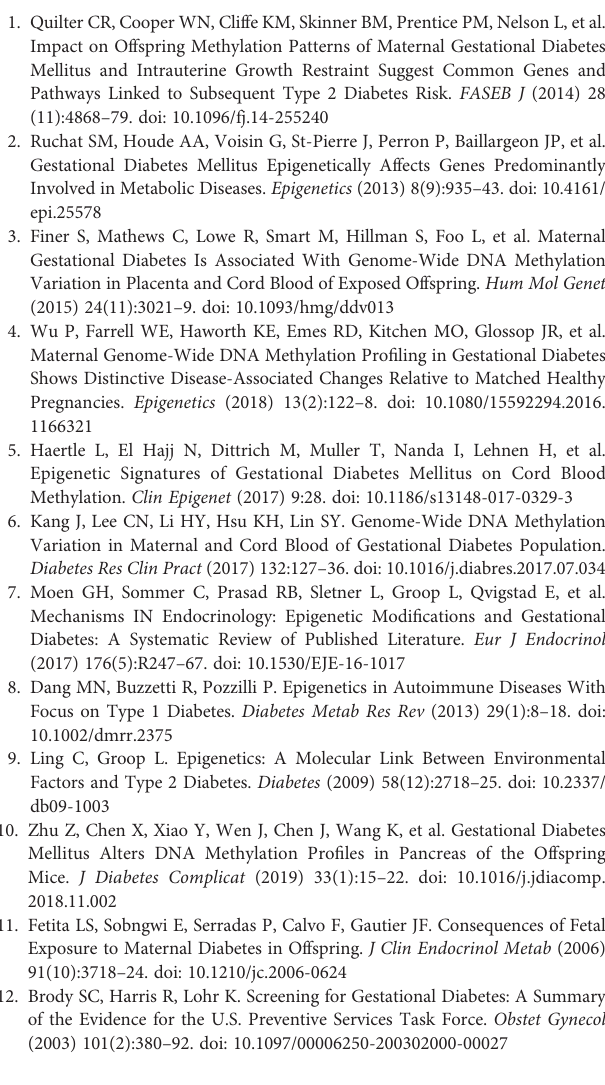
Supplementary Figure 3 | Correction of the genomic in fl ation factor (l). P-values were plotted using a Manhattan plot. QQ plots were plotted to show genomic in fl ation. Rlm analysis of DNA methylation in cord blood cells and continuous neonatal PG at 1 h after birth in 128 samples. Adding four covariates resulted in a l of 1.22. We considered PG at 1 h after birth to be signi fi cantly associated with DNA methylation sites after correcting the P-values with l (corrected to 1.1) (see Figure 1B ). Supplementary Figure 4 | Association for each cell type with PG at 1 h after birth associated methylation sites. (A) Veri fi cation of the P-values for associations with DNA methylation at each offour CpG sites in the CpG island chr8:144371446 – 144372076 (hg19)andPGat1hafterbirthbyaddingeachbloodcelltypeindividuallyasacovariate. Cell types not affecting the signi fi cance of the association between DNA methylation at cg11388673 and cg08799779. (B) QQ plots of analyses performed in (A) . Upper and lower rows indicate QQ plots before and after correction, respectively. (C) P-values following adjustment for the in fl ation factor and plotted with Manhattan plots. Data were derived from rlm analysis and adding individual cord blood cell types as covariates. Supplementary Figure 5 | The effect of each covariate on associations between DNA methylation and PG at1 h after birth. Each Manhattan plot shows the P-values derived from rlm analysis after correcting with the in fl ation factor and the addition of